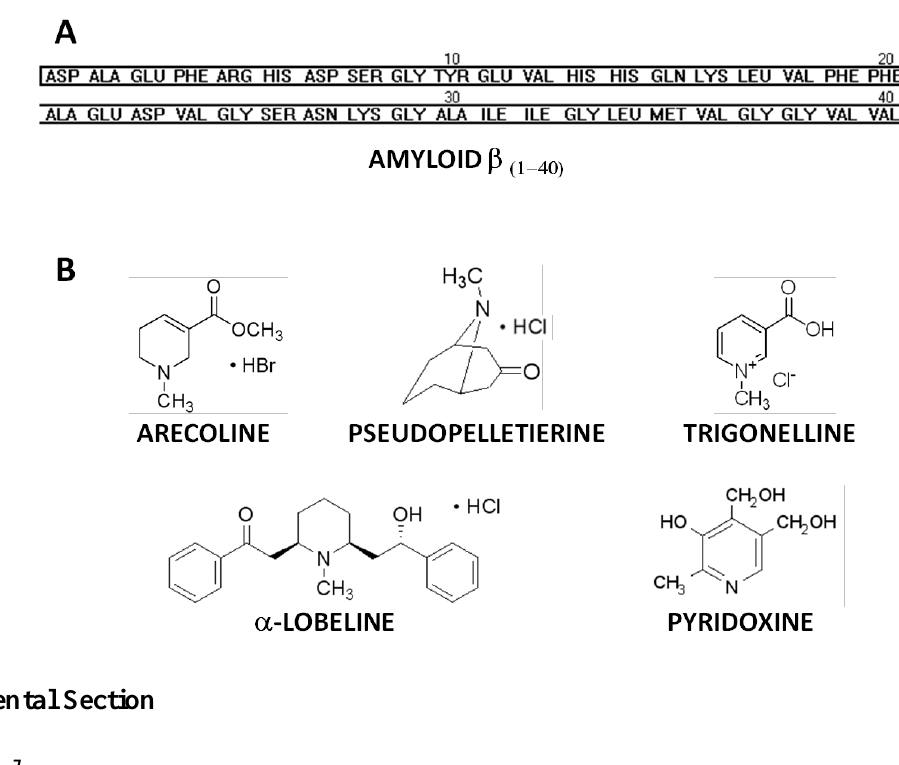
Figure 1. Amyloid β peptide (1–40) amino acid sequence ( A ) and chemical structure of tested compounds ( B